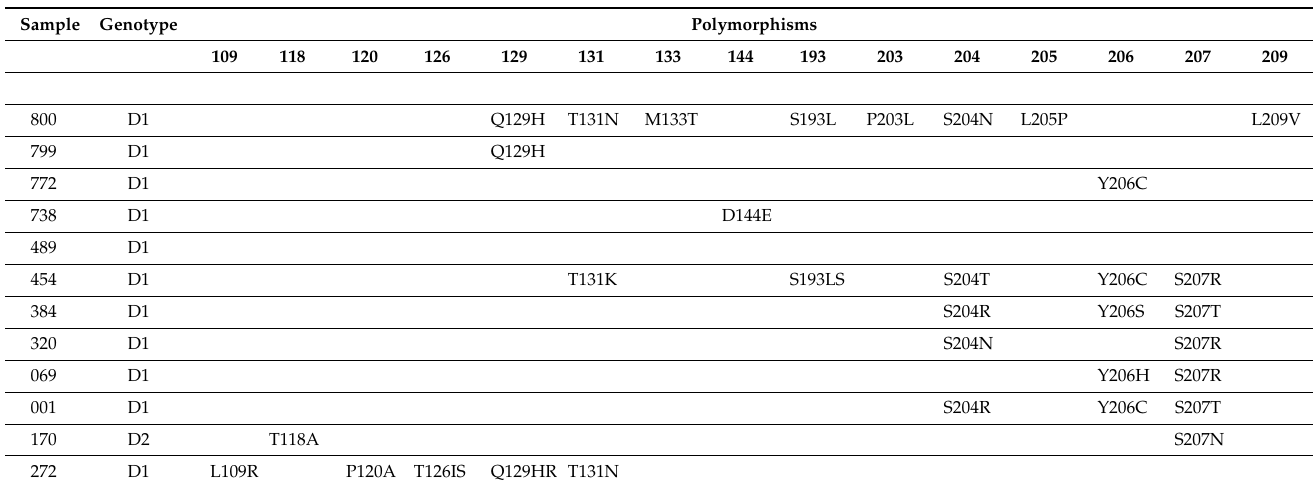
Table 3. Distribution of polymorphisms found for the surface gene of